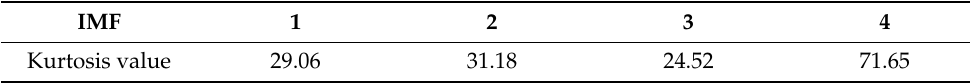
Table 1. Kurtosis values of IMFs for simulated signals.